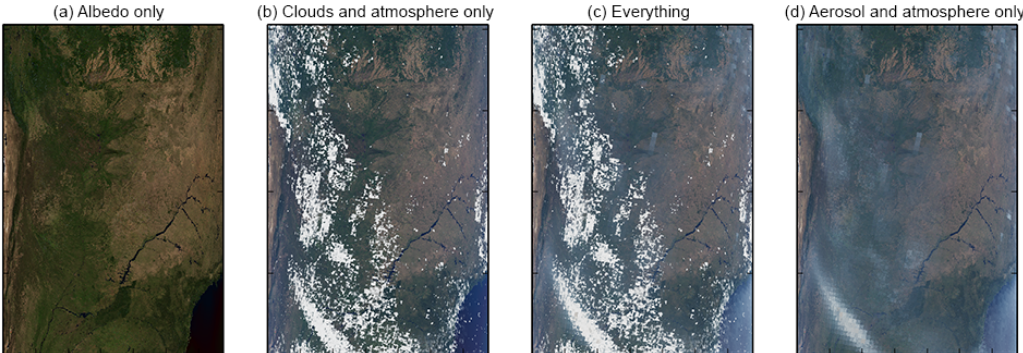
Figure 1. Example of various execution modes of the MCARS code using the Brazil 1 case 2012 day 252, 17:30UTC. Panel (a) shows the atmosphere-free image, just the surface albedo. Panel (b) shows the clouds-only simulation with no aerosols. Panel (c) has both clouds and aerosols and panel (d) shows the cloud-free mode, where cloud layers have been removed from the scene. Panels (b) , (c) , and (d) all include Rayleigh